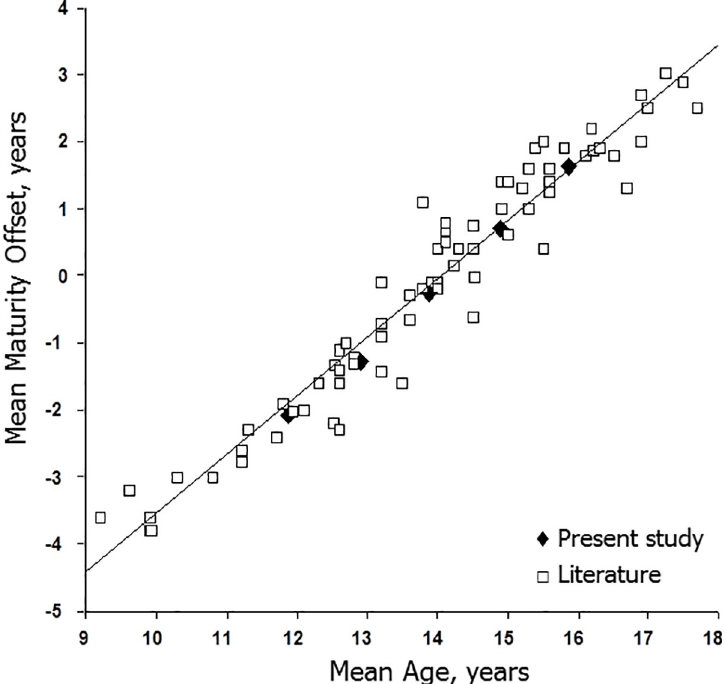
Fig 3. Means for predicted maturity offset (MO) plotted relative to means for chronological age for each year of observation in the current sample of players (filled diamonds) and in samples of male soccer players extracted from the literature (open squares; references: 13, 38, 43, 46,